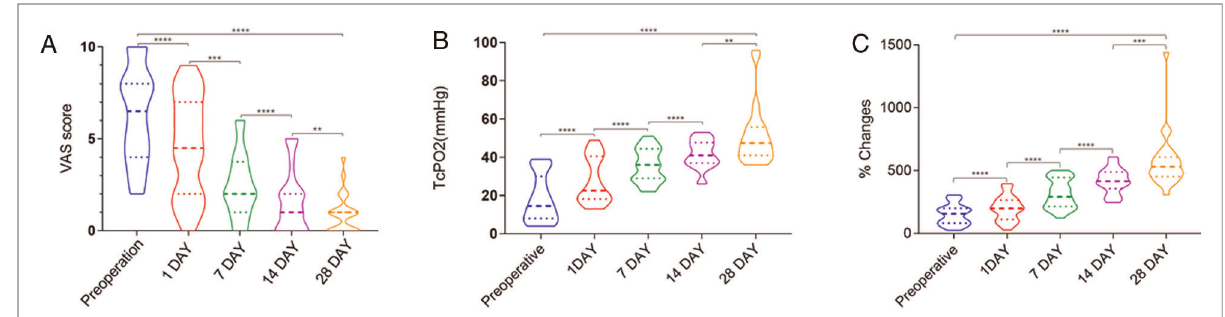
FIGURE 3 ( A ) Visual Analog Scale (VAS) pain score. The patients felt that the pain was signi fi cantly relieved after the operation (1 day, 7 days, 14 days, 28 days) compared with the preoperative period. ( B ) Transcutaneous oxygen pressure (TcPO 2). ( C ) % changes in blood perfusion. After the operation, the transcutaneous oxygen pressure and blood perfusion of the affected limb signi fi cantly increased. ****, P <0.0001; ***, P <0.001;**, P <0.01; *, P